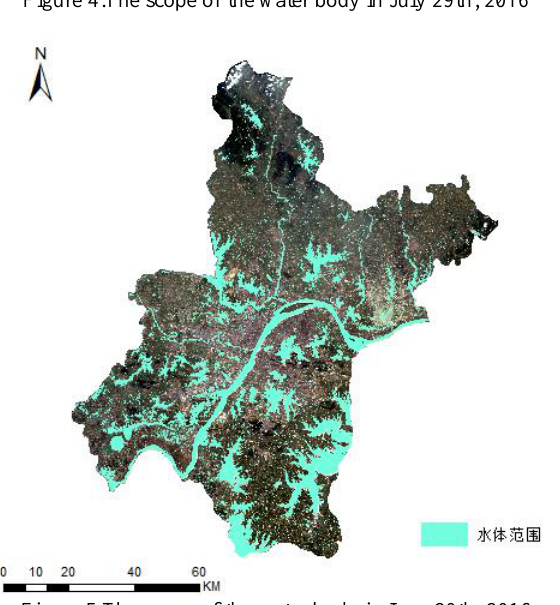
Figure 4.The scope of the water body in July 29th, 2016